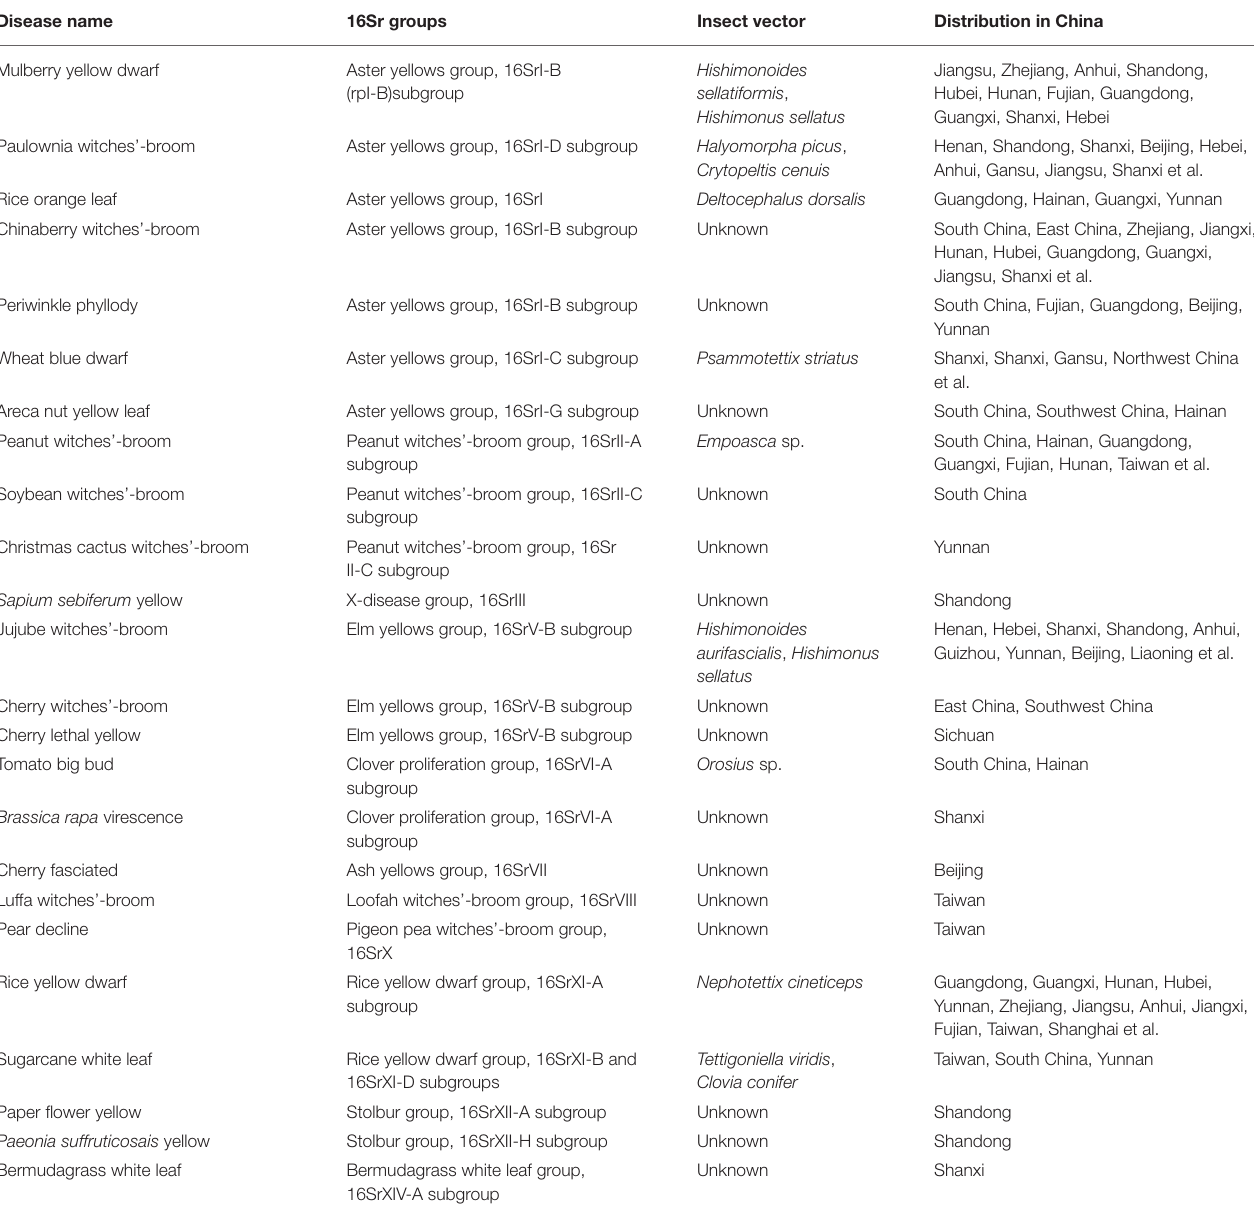
TABLE 1 | List of main plant phytoplasma disease in